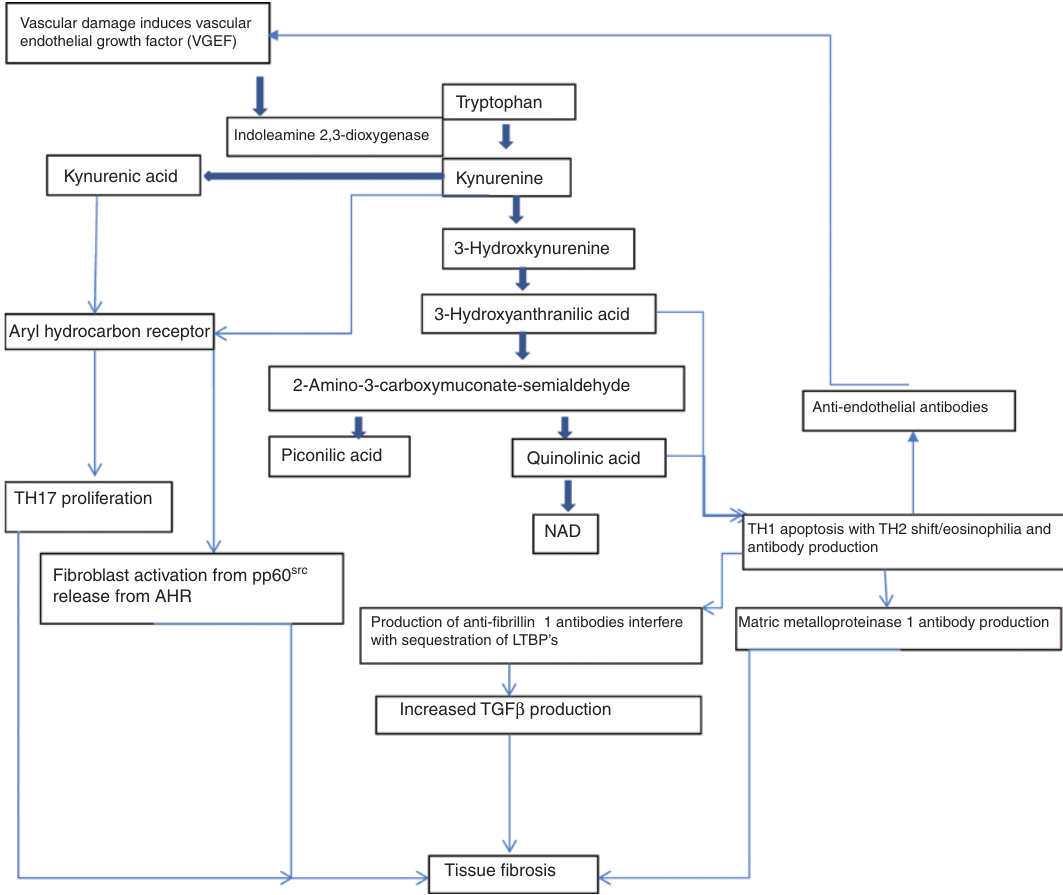
Figure 2: Proposed model outlining the involvement of the kynurenine pathway in